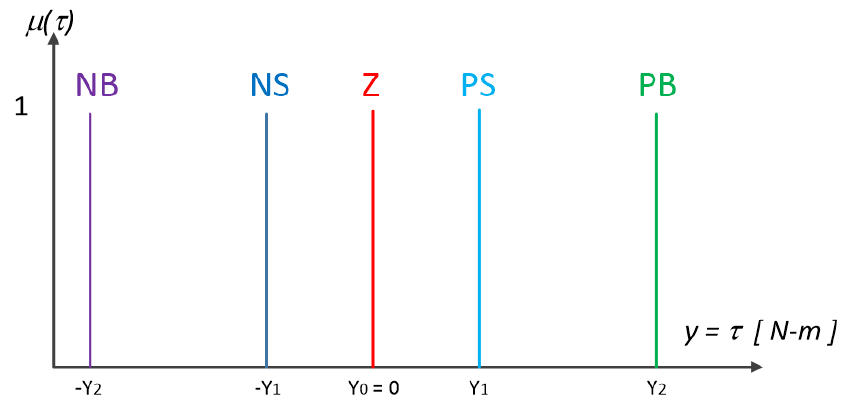
Figure 12. Fuzzy sets for output τ .